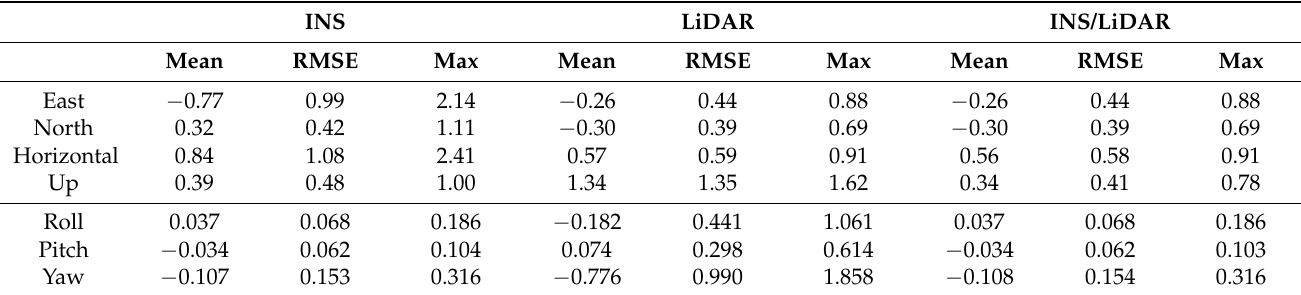
Table A12. D-46—position (m) and attitude (deg) error statistics.